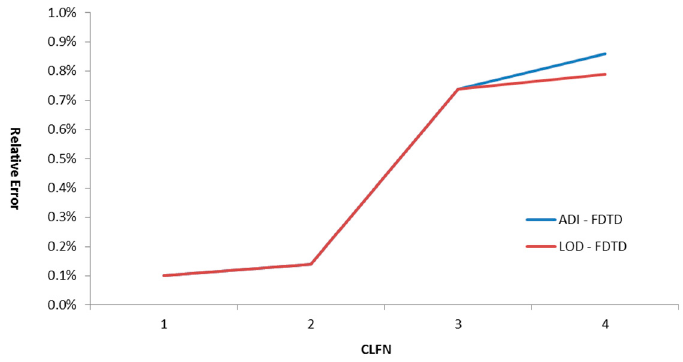
Figure 6. Comparative accuracy with respect to CFLN for an OWS.